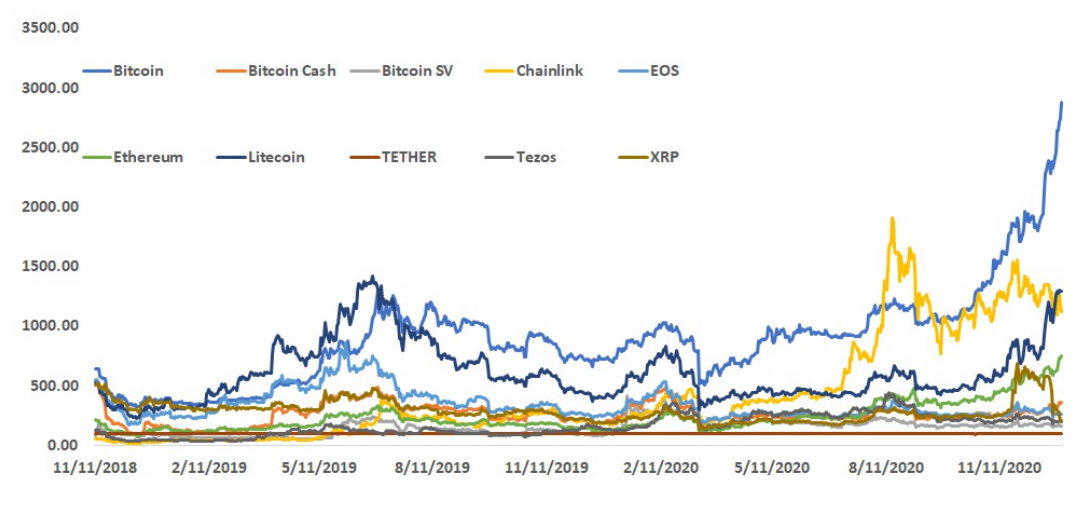
Figure 1. This figure plots daily prices for ten cryptocurrencies from 11 November 2018 to 31 December 2020. We scaled the prices of cryptocurrency to fit in one plot.